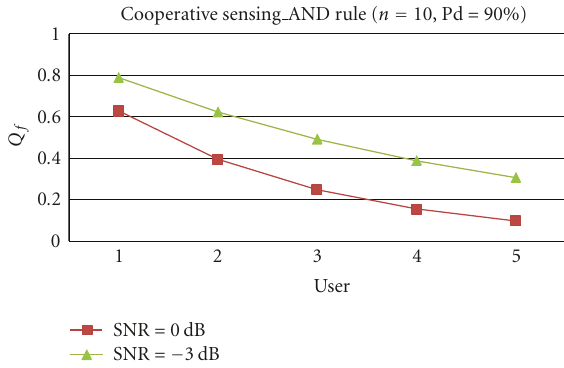
Figure 12: Impact of sensing period to MPEG-4 video transmis- sion.